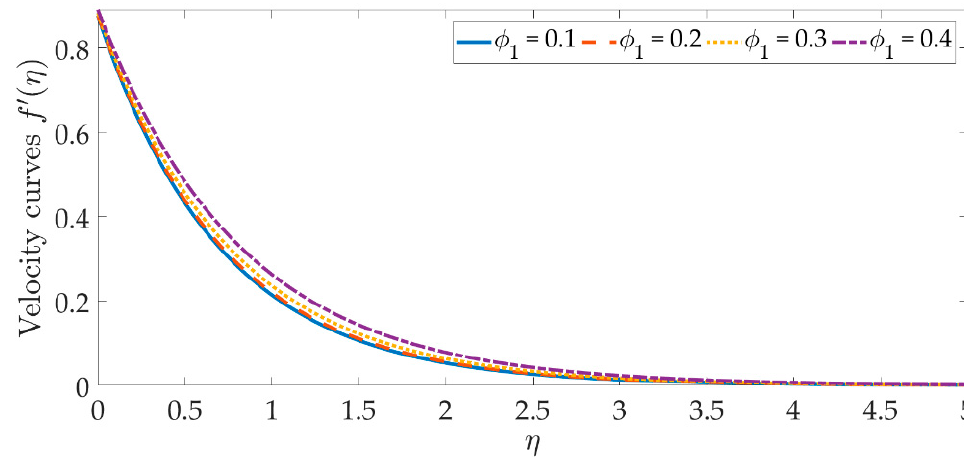
f Figure 3. Velocity curves against the multiple values of φ 1 .